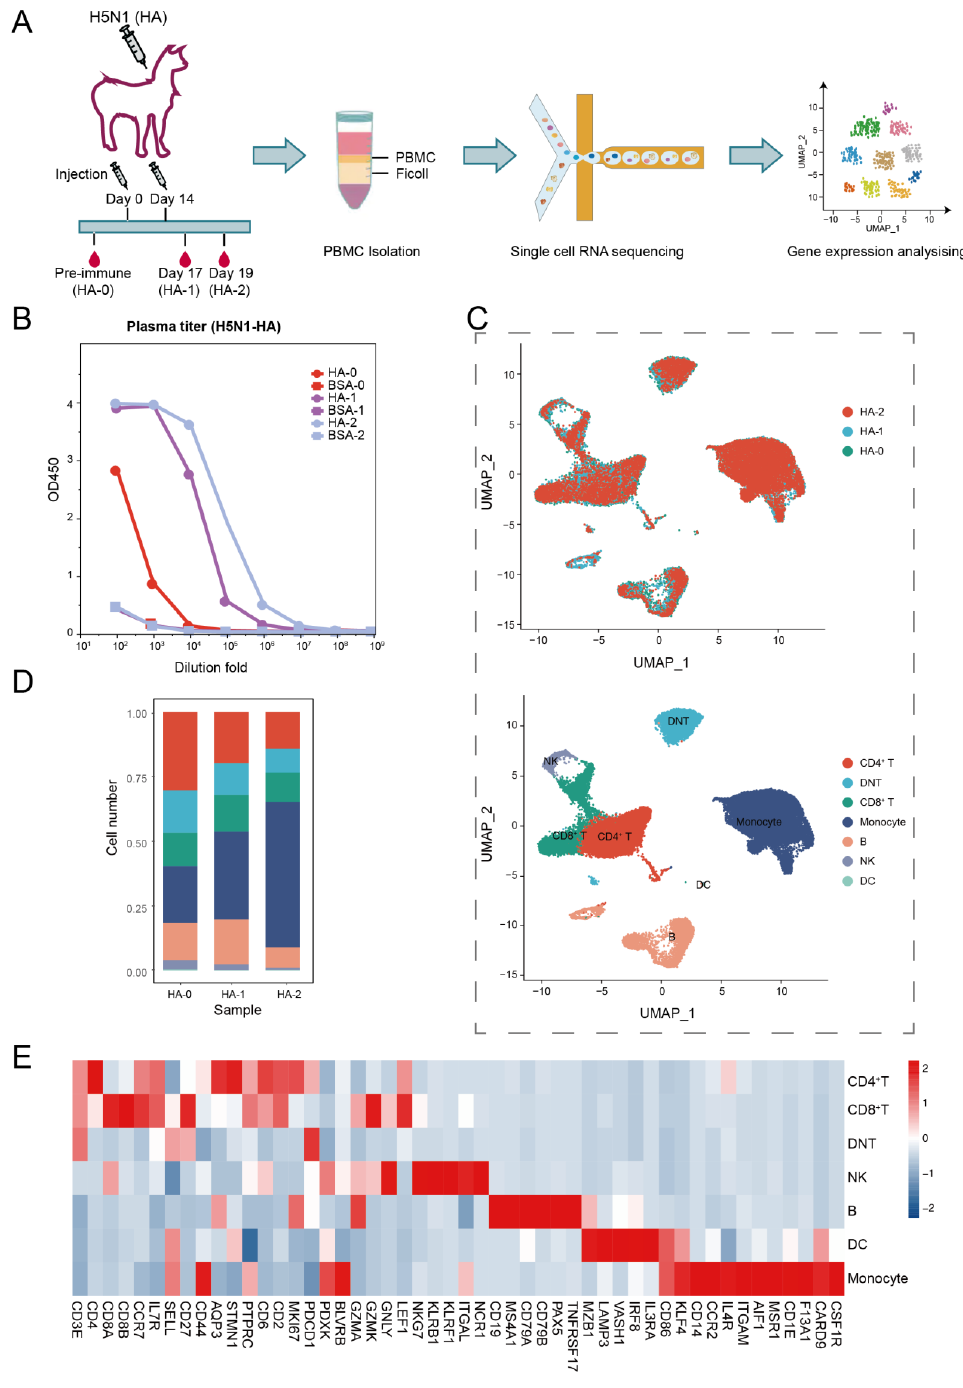
Figure 1. Study design and single-cell dynamic landscape of HA-stimulated PBMCs in the alpaca. ( A ) The alpaca received HA stimulations two times, and blood samples were taken from the alpaca at three time points before and after stimulations. Then, scRNA-seq dynamic analyses were conducted. ( B ) Line plots display the result of the ELISA binding assay testing the titer of the HA-specific antibody in alpaca serum. ( C ) Top: UMAP plot shows HA-0, HA-1, and HA-2 in three colors indicating no batch effects; Bottom: UMAP plot shows seven major cell types of 35,853 immune cells by unsupervised clustering. Cells are colored by clusters. ( D ) Histogram shows the cell proportion of PBMC at different time points. ( E ) Heatmap shows representative marker expression patterns, which annotate clusters to related cell types.